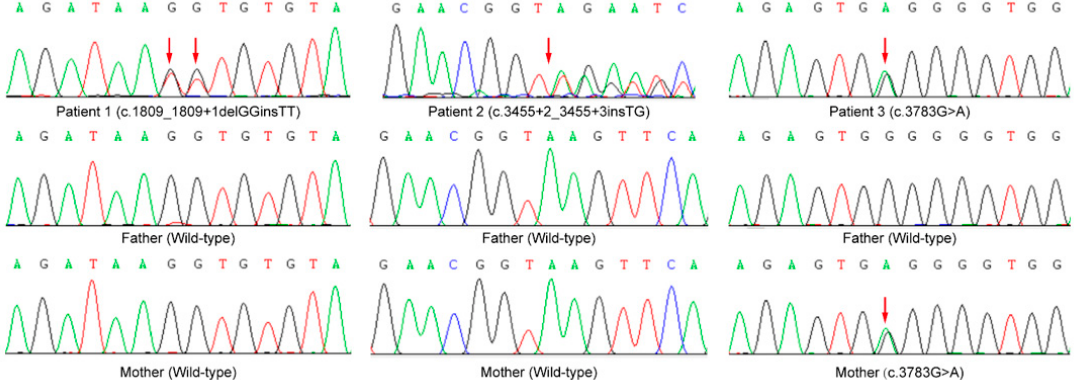
Figure 1. CHD2 variants validated by Sanger